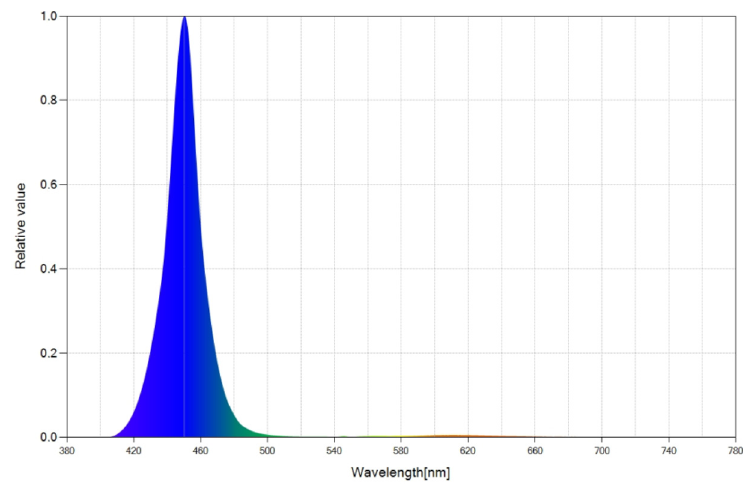
Figure 1. Spectral power distribution (peaking at 450 nm) of selected blue LED chip.